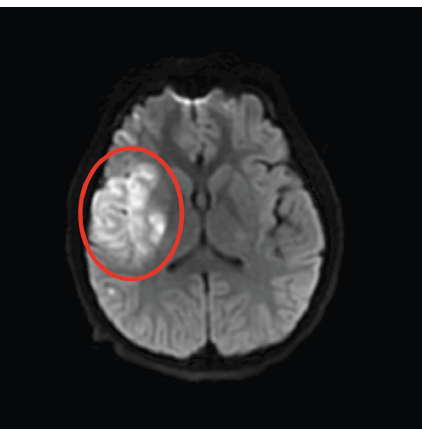
Figure 3: 3D reconstruction of the CTA showing poor filling and blood flow in the right MCA.